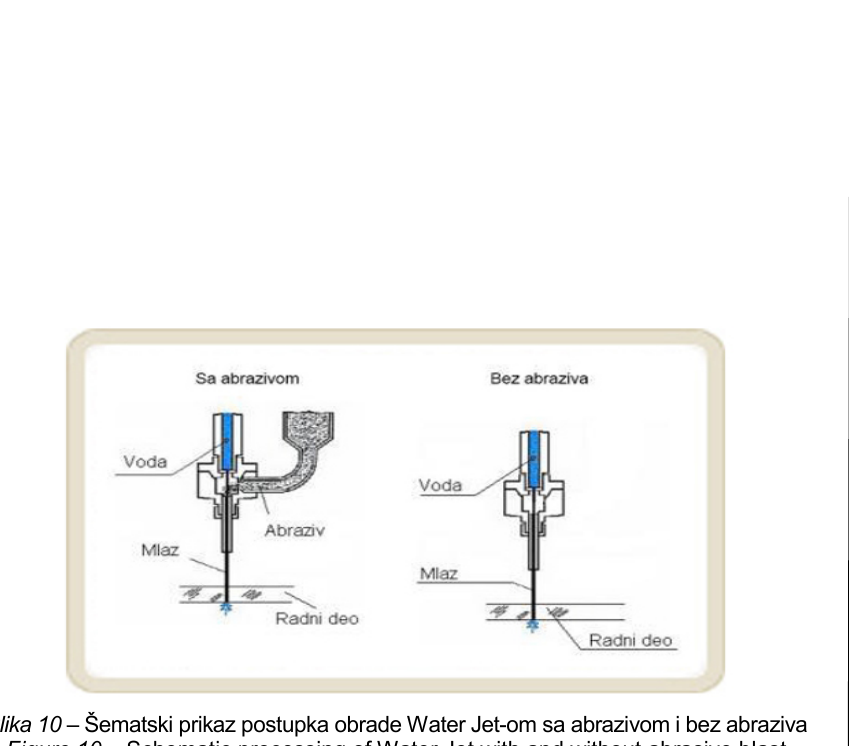
Figure 10 – Schematic processing of Water Jet with and without abrasive